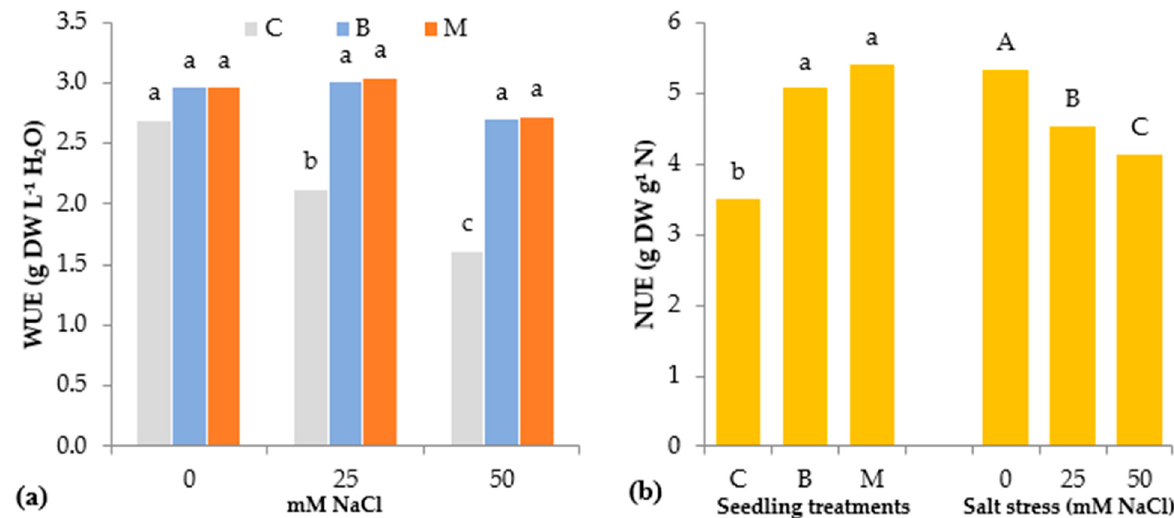
Figure 3 . Effect of the seedling treatments (C, not treated; B, Bactor S13 ; M, Micorrize) and salt stress (0, 25, and 50 mM NaCl in the irrigation water) on ( a ) the water use efficiency (WUE) and ( b ) the nitrogen use efficiency (NUE) of lettuce seedlings (bars with different uppercase or lowercase letters are significantly different at p < 0.05 according to the LSD test).